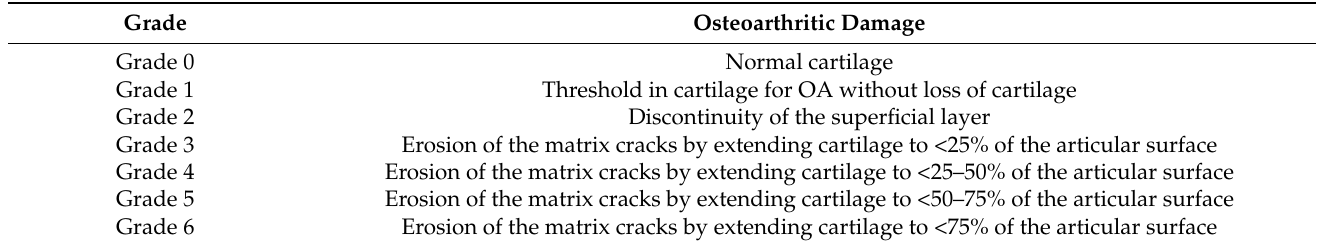
Table 1. Osteoarthritis Research Society International (OARSI)